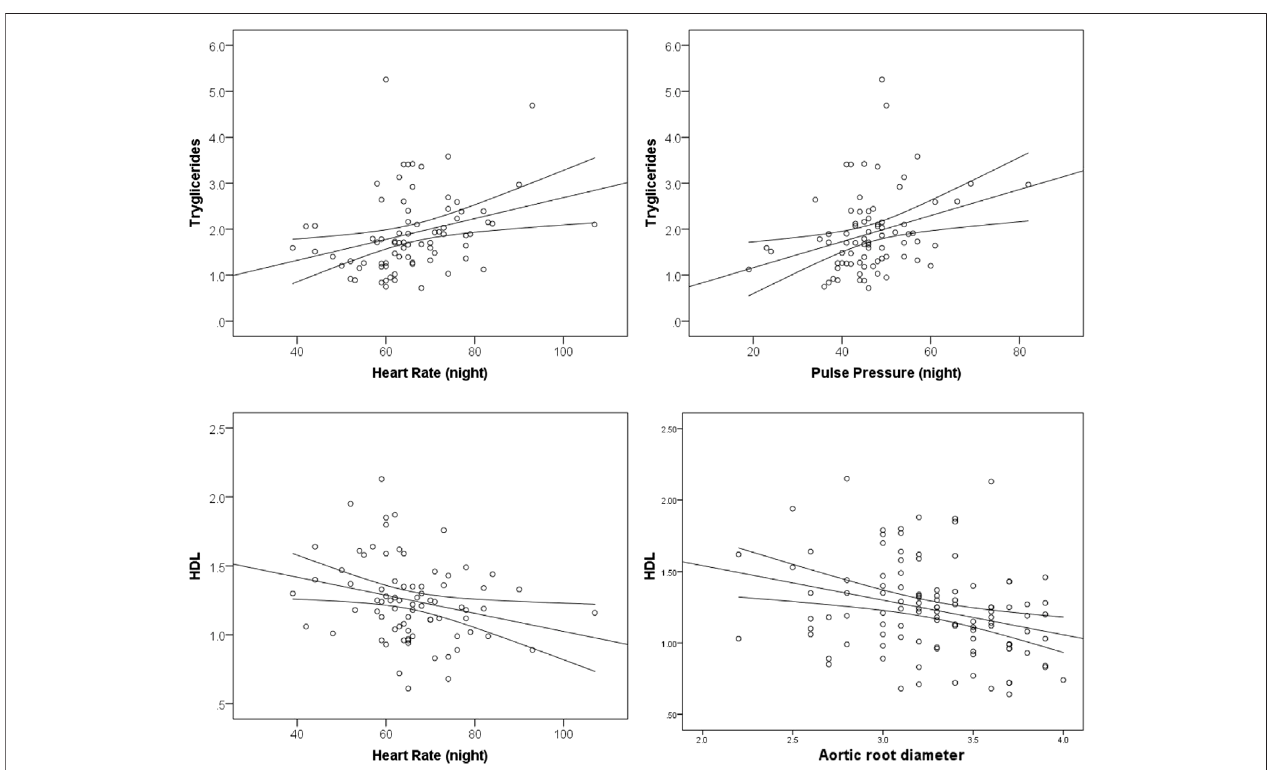
FIGURE 2 | Correlation between tryglicerides, HDL and cardiovascular